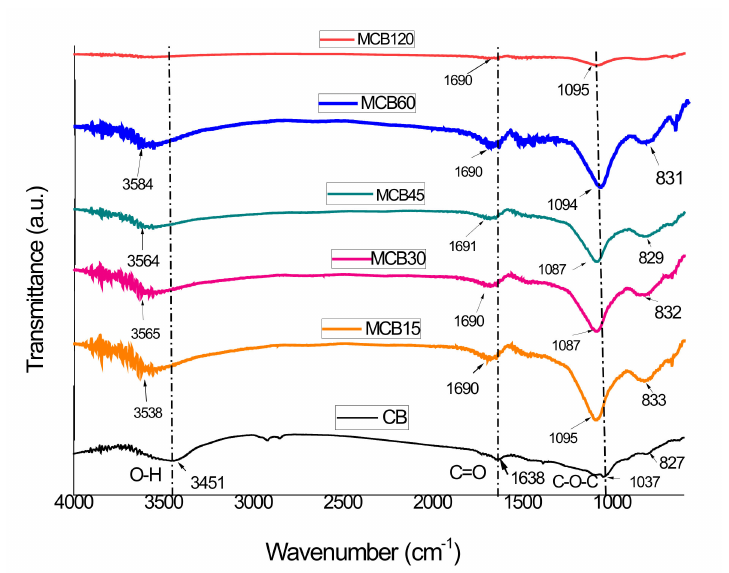
Figure 2. FTIR spectra of the unmodified carbon black and the modified carbon black with citric acid.